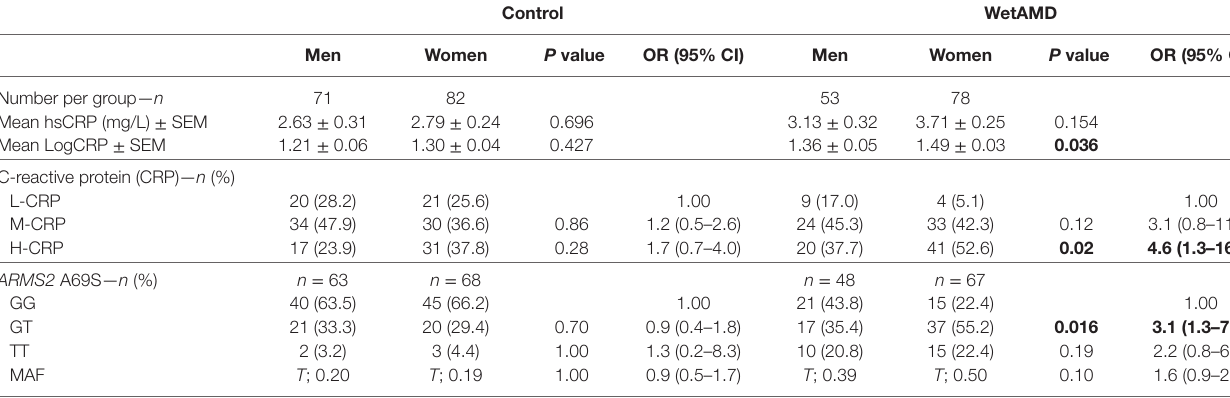
Table 4 | Subgroup analysis for control and wetAMD individuals divided into gender, according to CRP groups and genotype frequencies. control